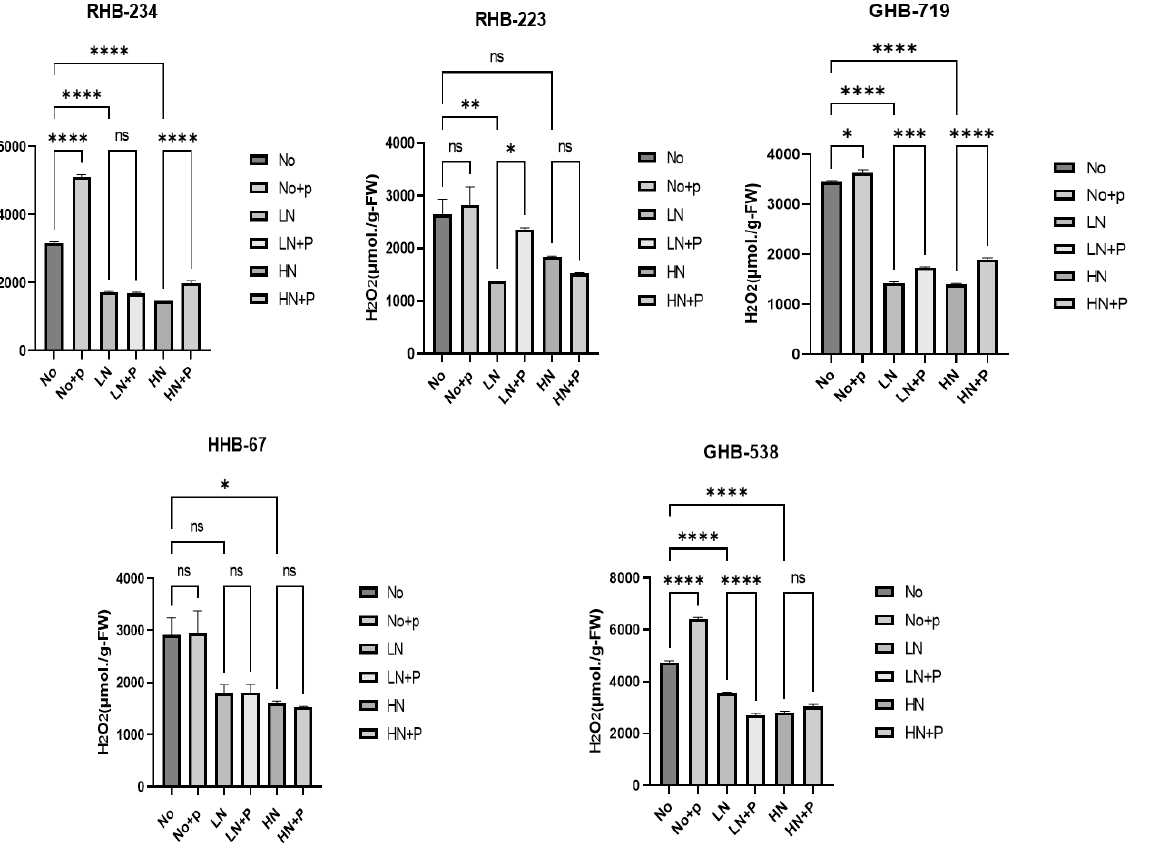
Figure 5. Hydrogen peroxide content in the shoot of pearl millet treated with different N and drought stress (PEG-6000-10%). Bars are means ± standard error (n = 3). In the above bar (****, ***, **, *) represents differences among treatments (Tukey’s test, p ≤ 0.0001), while ns represents no significant difference.